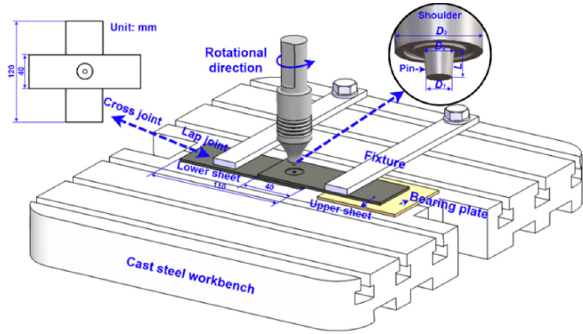
Figure 1. Schematic diagram of the friction stir spot-welded (FSSW) process and its detailed dimensions. Table 3. Specification of the used tools.